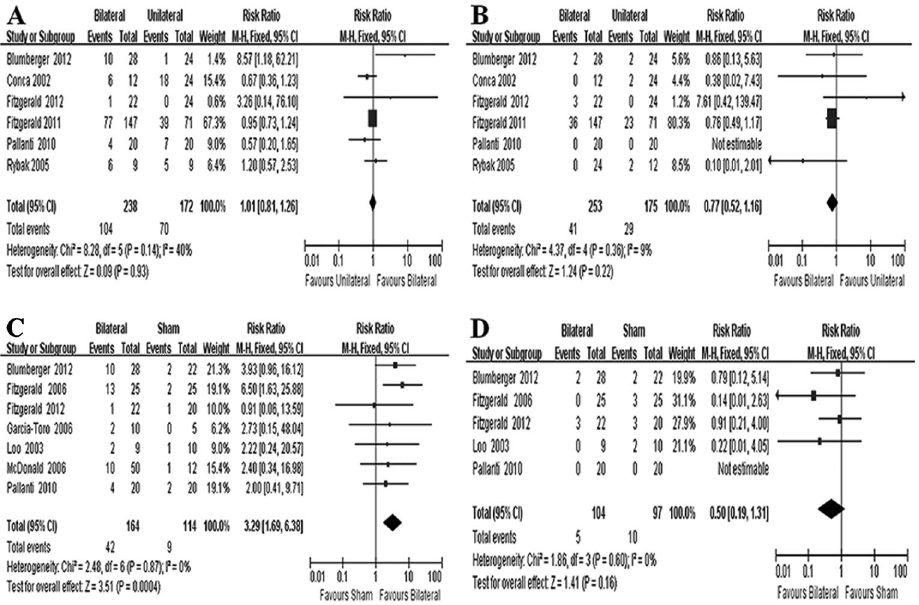
Figure 3. Subgroup analyses: bilateral vs unilateral repetitive transcranial magnetic stimulation (rTMS) and bilateral vs sham rTMS. A , Comparison of bilateral vs unilateral rTMS for primary outcome; B , comparison of bilateral vs unilateral rTMS for secondary outcome; C , comparison of bilateral vs sham rTMS for primary outcome; D , comparison of bilateral vs sham rTMS for secondary outcome.